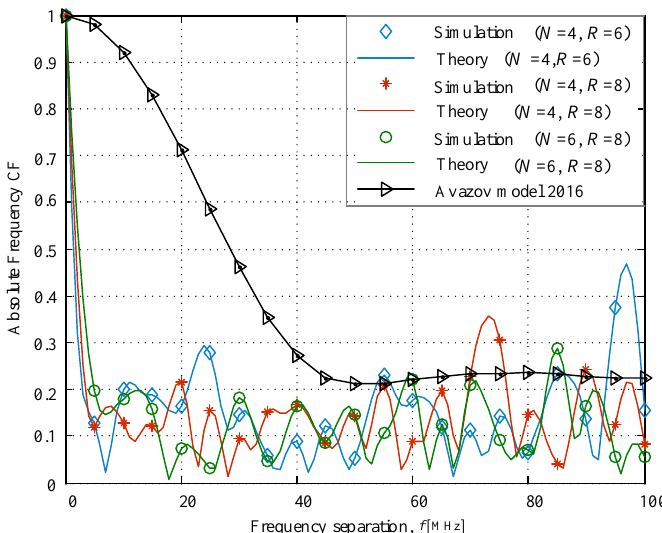
Figure 5. Proposed frequency CFs for the LoS and NLoS paths in terms of the reflection number N and the radius of the tunnel R when M T = M R = 4, γ T = 2 π /3 , γ R = π /6, v R = 54 km/h, and φ v = pi /3